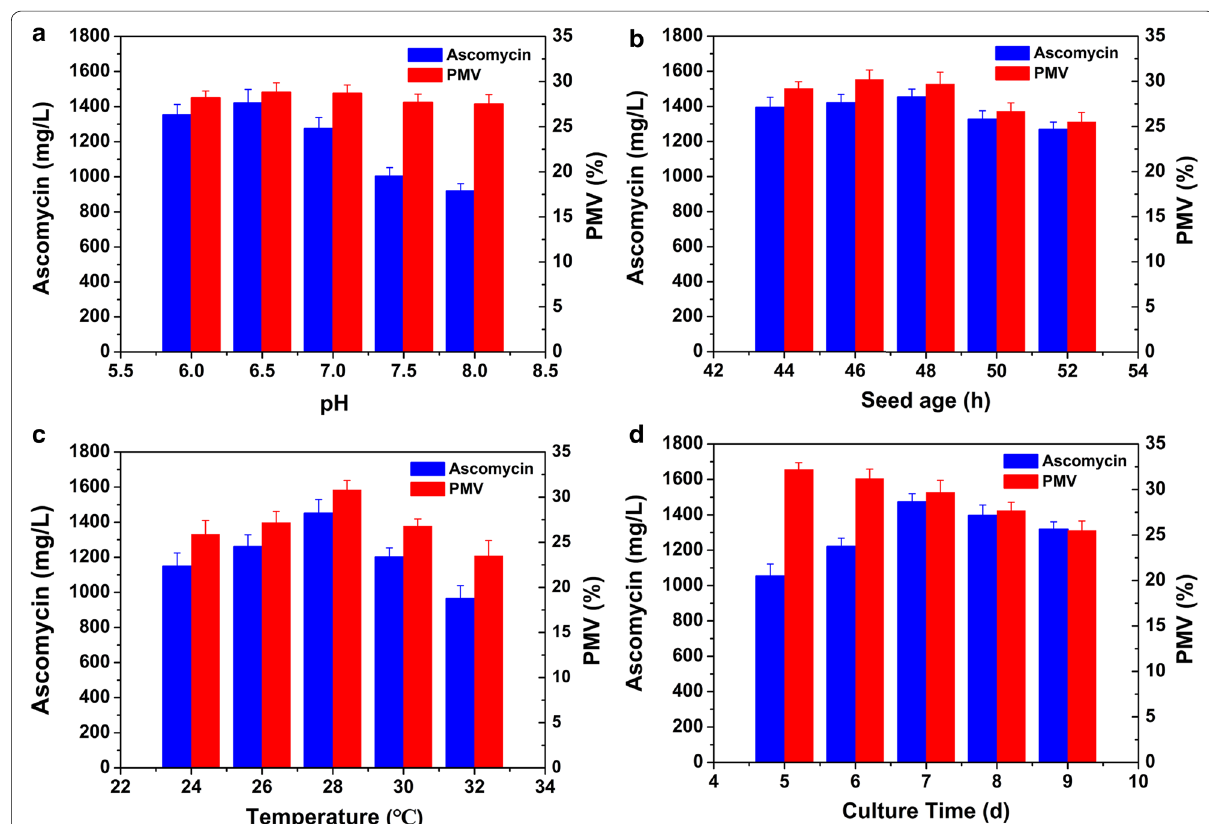
Fig. 6 Optimization of fermentation conditions for ascomycin production by S. hygroscopicus SFK-36 in shake flasks. Effect of pH ( a ), seed age ( b ), temperature ( c ), culture time ( d ) on ascomycin production and biomass of